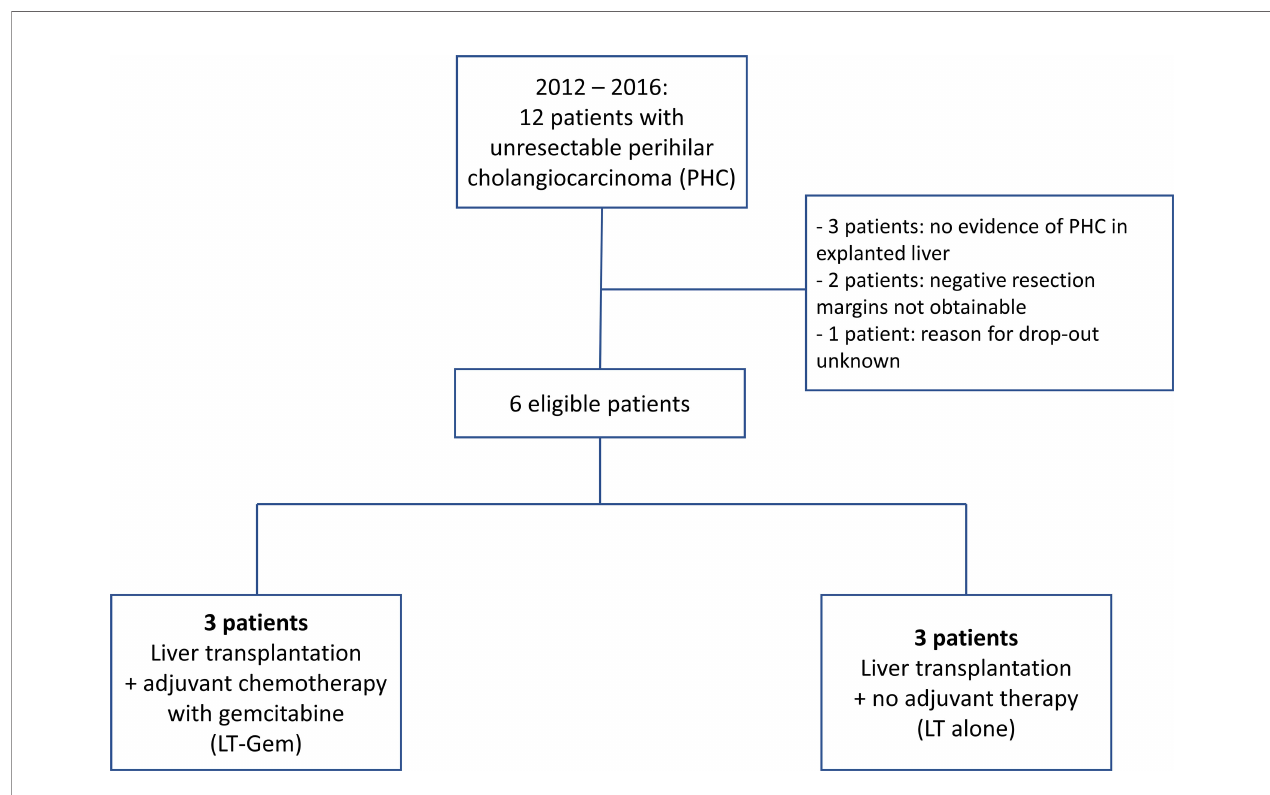
FIGURE 1 | CONSORT fl ow chart of